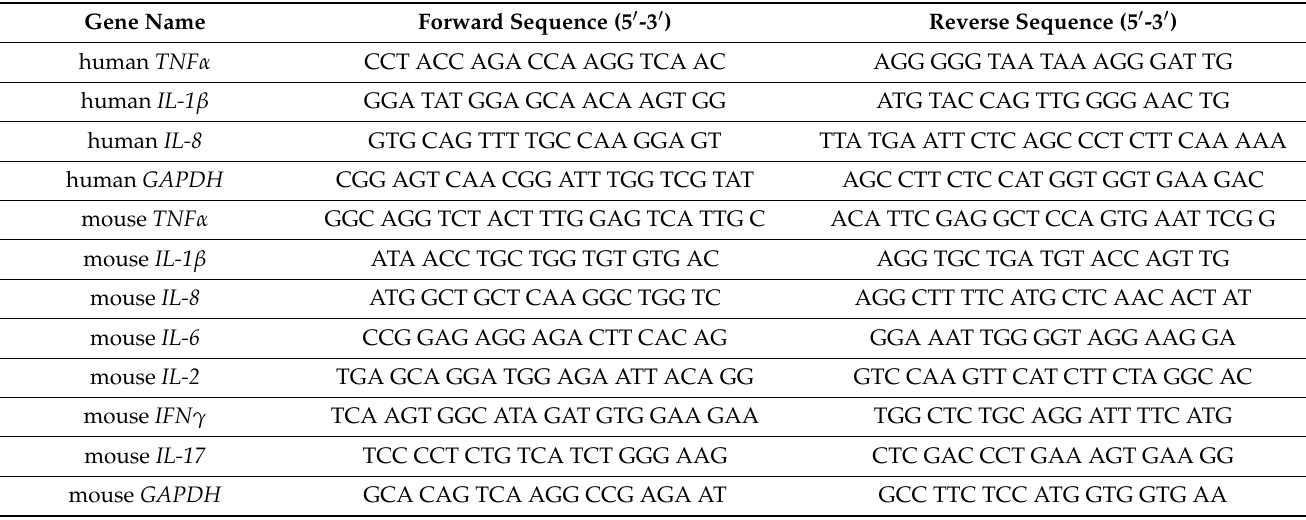
Table 1. Primer sequence used for the quantitative real-time PCR